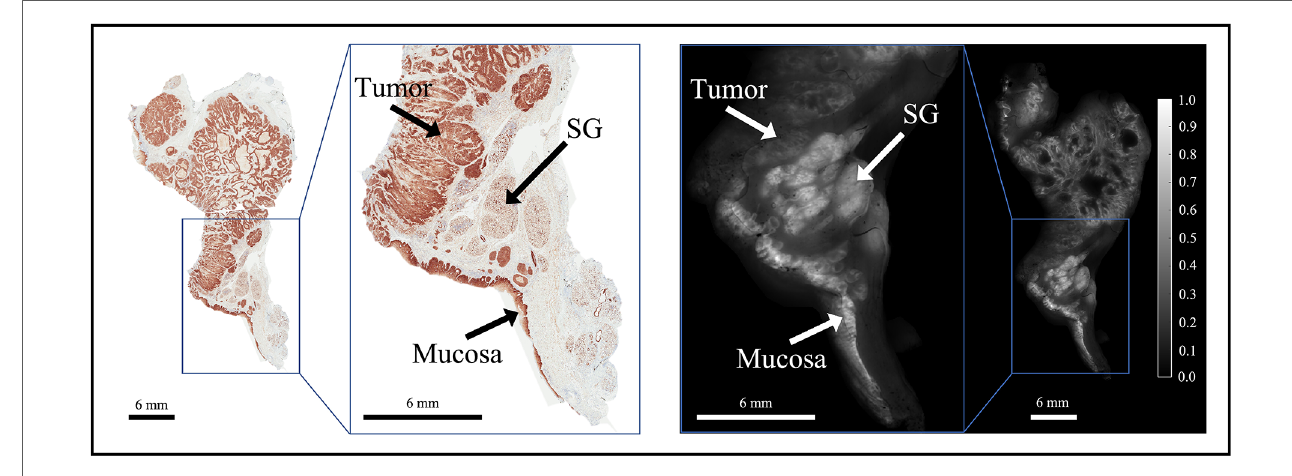
FIGURE 1 Representative bread-loafed slice of a head and neck cancer displaying normal and tumor-derived EGFR expression. EGFR IHC staining ( left ) and fl uorescence ( right ) images of slice #16 from dose group 2. Arrows annotate EGFR-positive tissues including tumor, salivary gland (SG), and mucosa on the EGFR IHC staining and fl uorescence images,